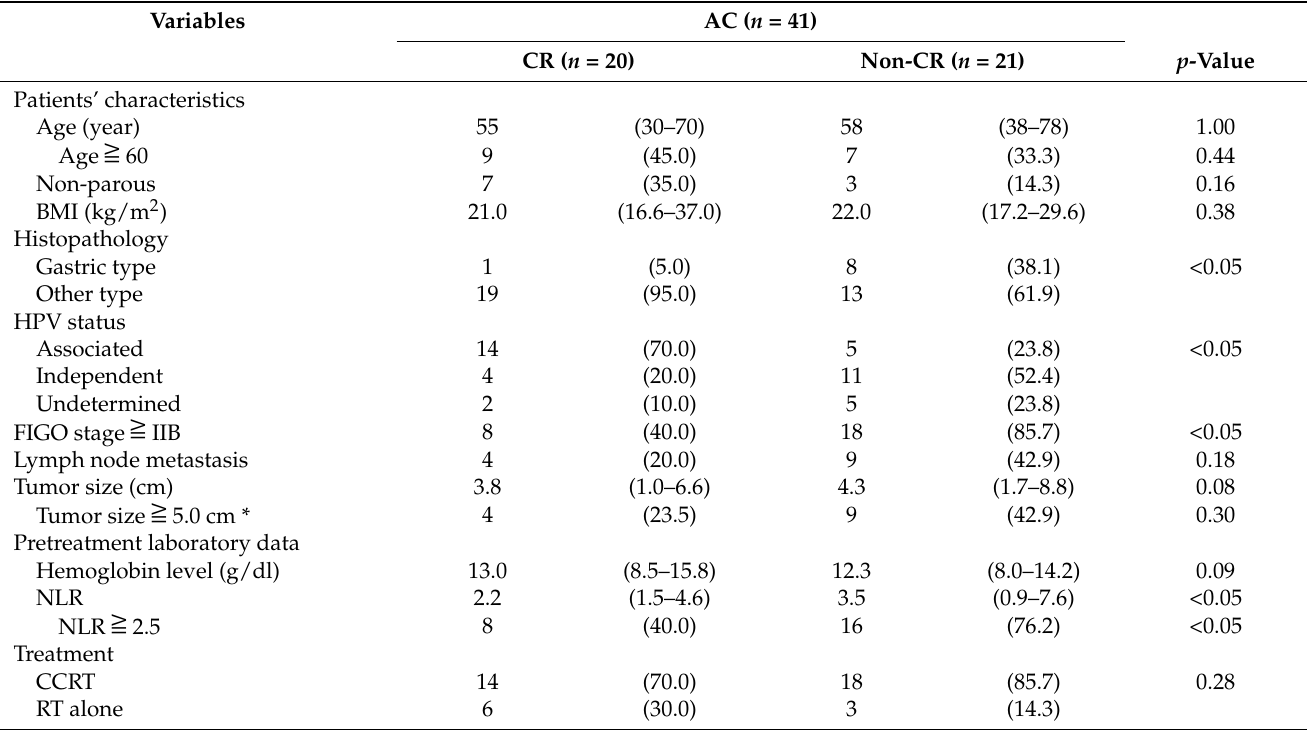
*Adjusted for FIGO stage, histology, tumor size, and NLR. ** Three patients had missing data. Abbreviations: CR, complete response; AC, adenocarcinoma; cOR, crude odds ratio; aOR, adjusted odds ratio; CI, confidence interval; FIGO, International Federation of Gynecology and Obstetrics;